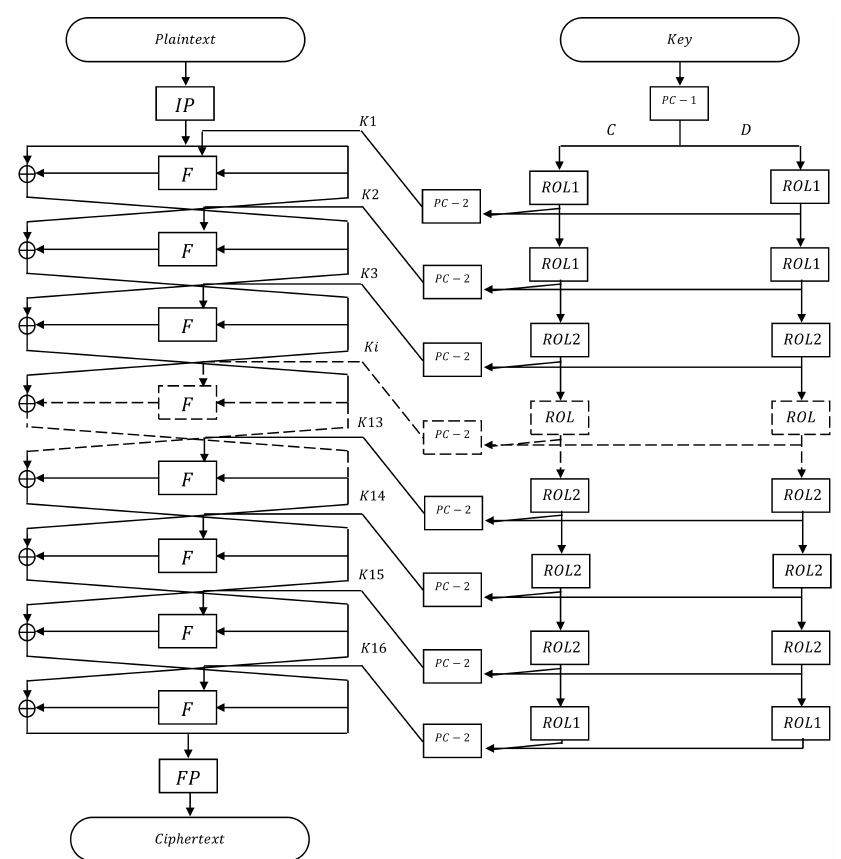
Figure 1: Outline of The Data Encryption